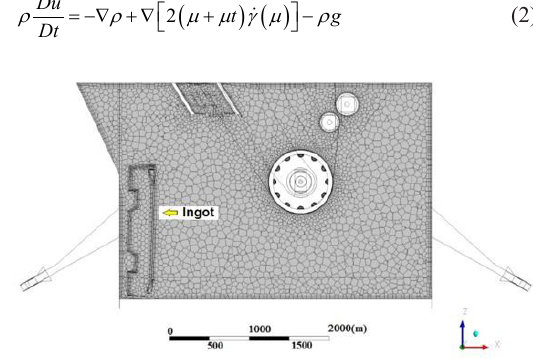
Figure 1. Basic layout of a galvanizing pot with ingot 100% immersed in the bath.